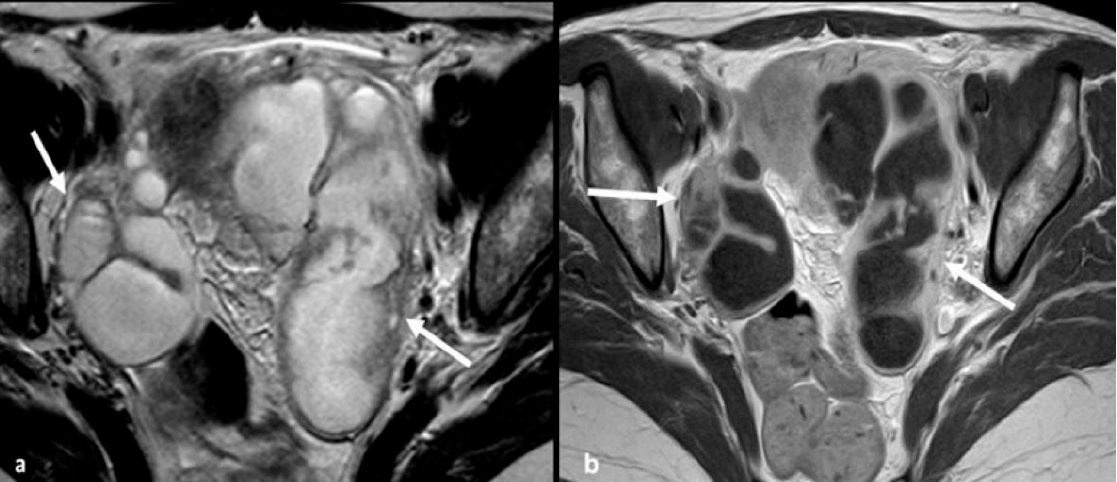
Figure 12. Acute pelvic inflammatory disease. Axial T2 weighted image ( a ) shows large tubular pelvic structures bilaterally (arrows) with thick, smooth walls and incomplete folds, containing non-simple fluid, consistent with dilated tubes. Corresponding T1 weighted contrast-enhanced image ( b ) demonstrates enhancement of the tubal wall but no internal enhancing solid tissue.